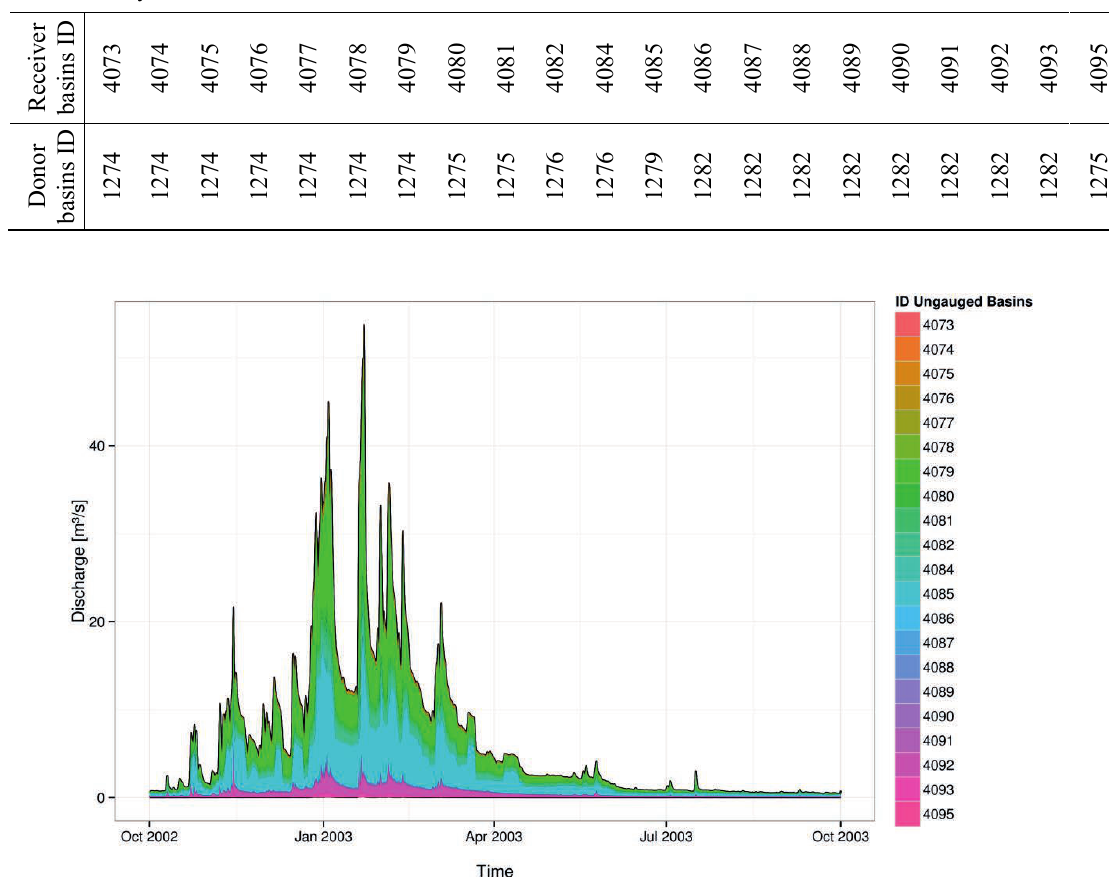
Table 2 Transpositions performed for modelling the total volume of freshwater flowing into the Saint- Brieuc’s Bay.